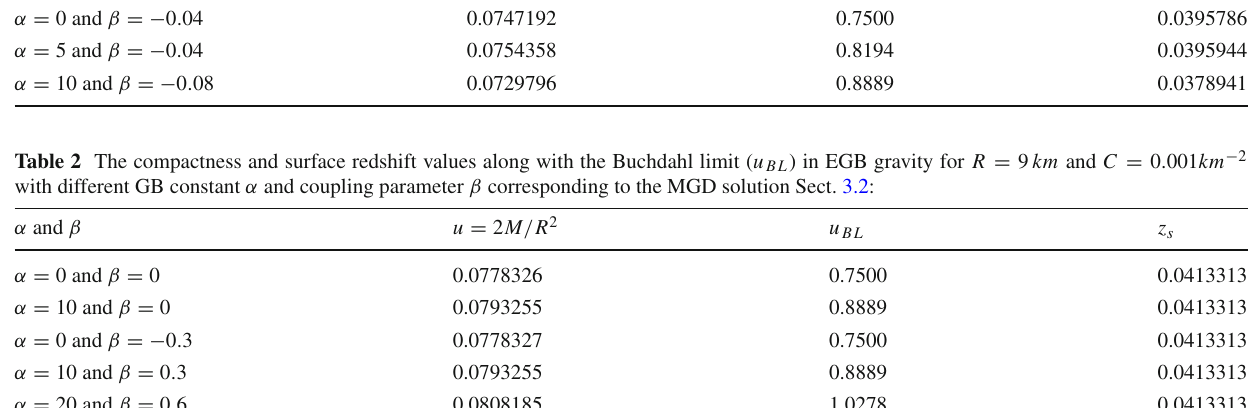
Table 1 The compactness and surface redshift values along with the Buchdahl limit ( u BL ) in EGB gravity for R = 9 km and C = 0 . 001 km − 2 with different GB constant α and coupling parameter β corresponding to the MGD solution Sect. 3.1: α and β u = 2 M / R 2 u α = 0 and β = 0 0.0778326